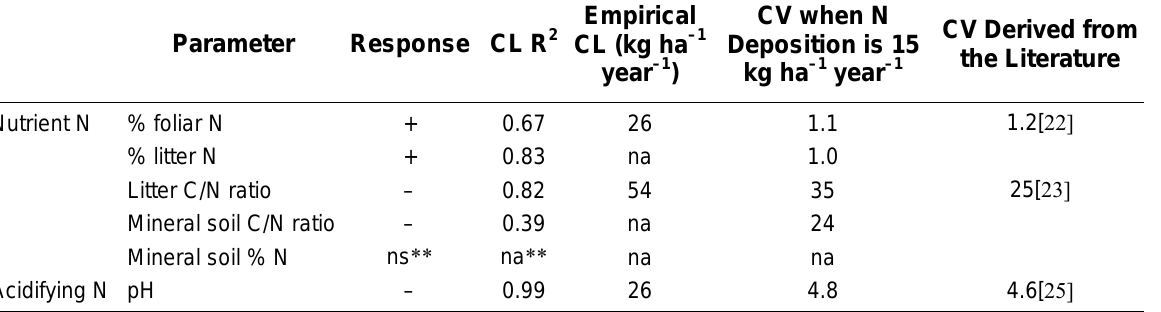
Calculation of Empirical Critical Loads (CL) and Critical Values (CV)*